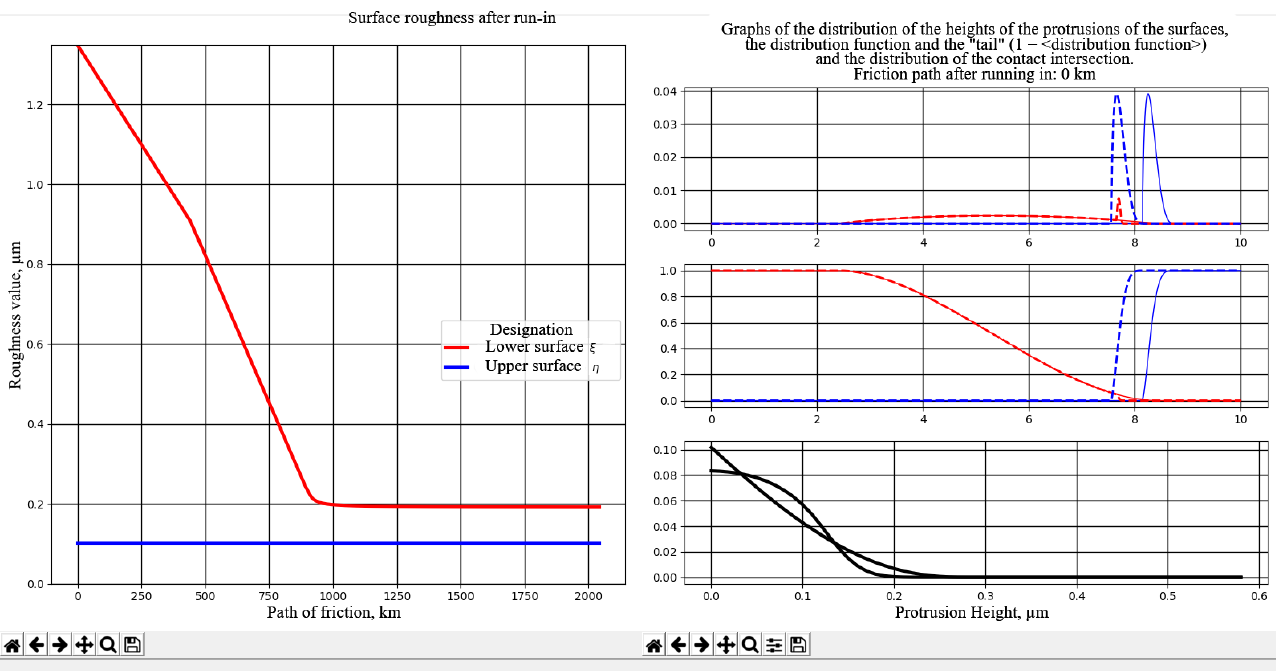
Figure A2. Program window reflecting friction characteristics.